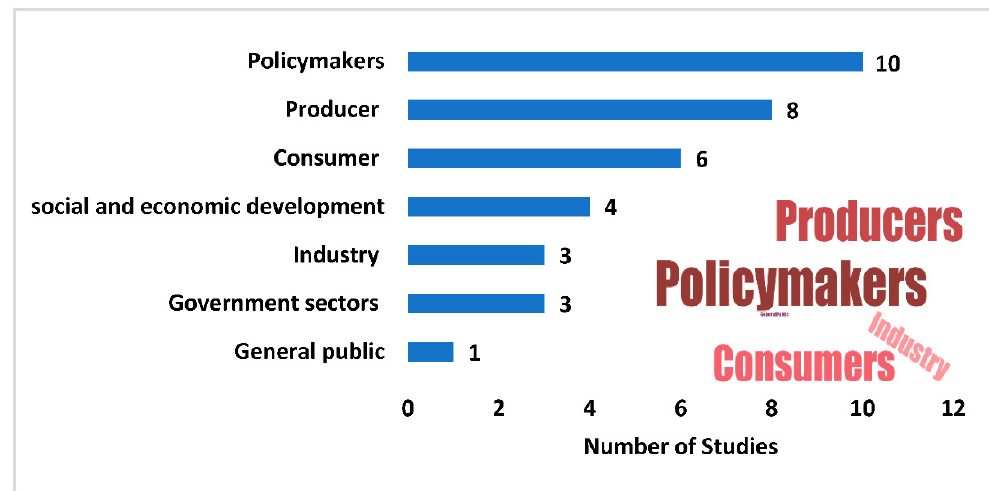
Figure 5. Quantitative and qualitative representation of the common aims of LCA from the litera- ture.